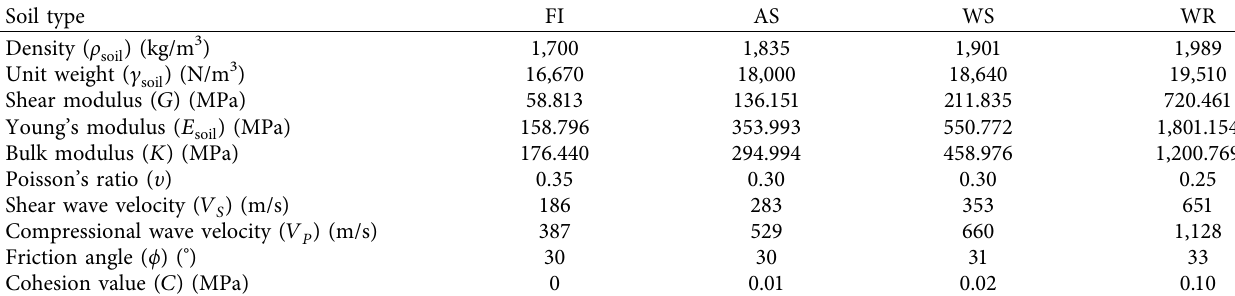
Table 2: Geotechnical properties of four types of soil applied to the SSI analysis.